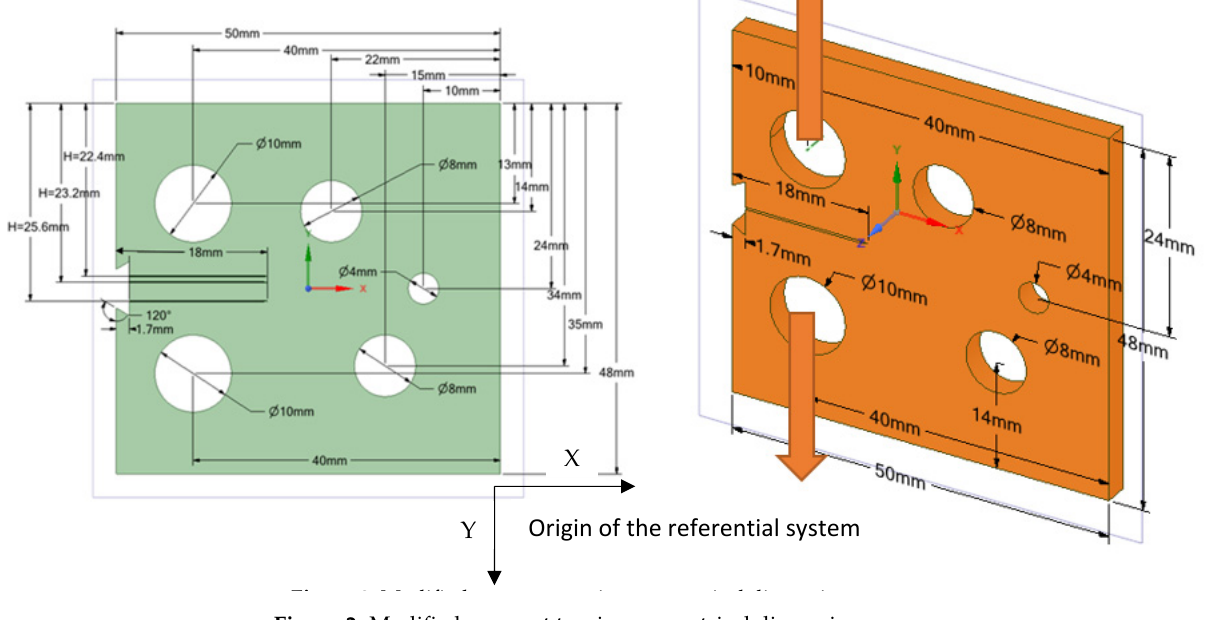
Table 1. Mechanical properties of the nickel-based superalloy material.